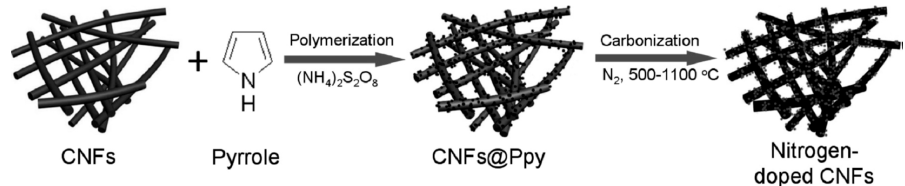
Figure 6. Schematic illustration for the fabrication processes of nitrogen-doped CNFs. Reprinted with permission from [75]. permission from